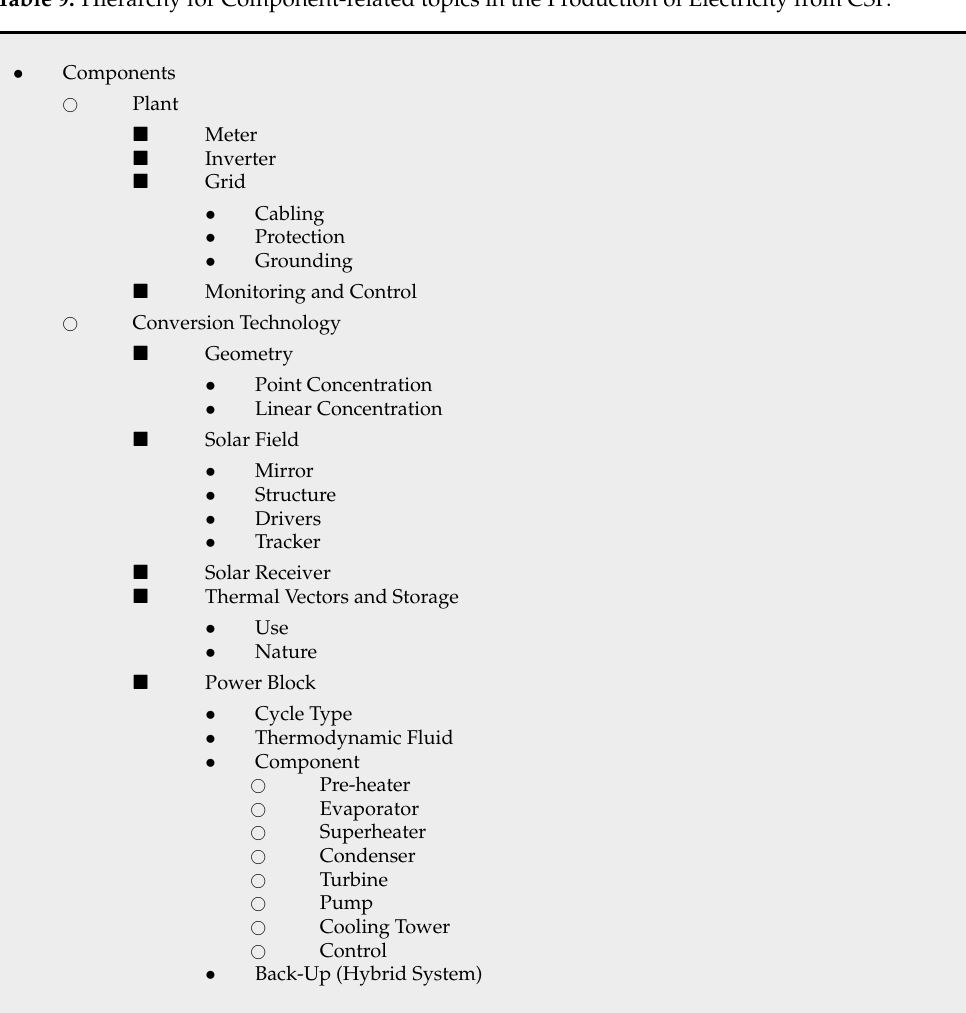
Table 9. Hierarchy for Component-related topics in the Production of Electricity from